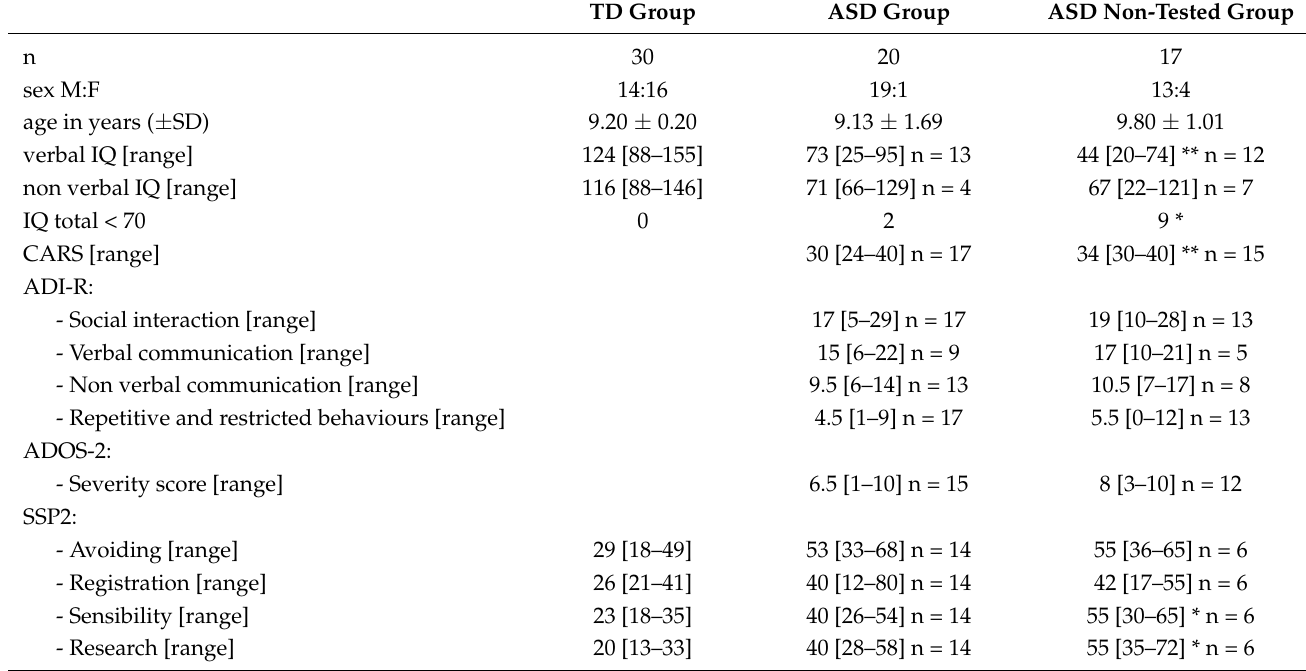
Table 1. Demographic and clinical data for TD and ASD groups, and ASD non-tested group. Values are expressed in mean ± standard deviation (age) and mean with range (minimum and maximum values) for clinical data. n: number of children for whom the scores could be collected. Statistical differences between the ASD and ASD non-tested groups are reported. *: p < 0.05, **: p < 0.01. See Supplementary Materials for detailed statistical results and Figure S1 for SSP2 differences.